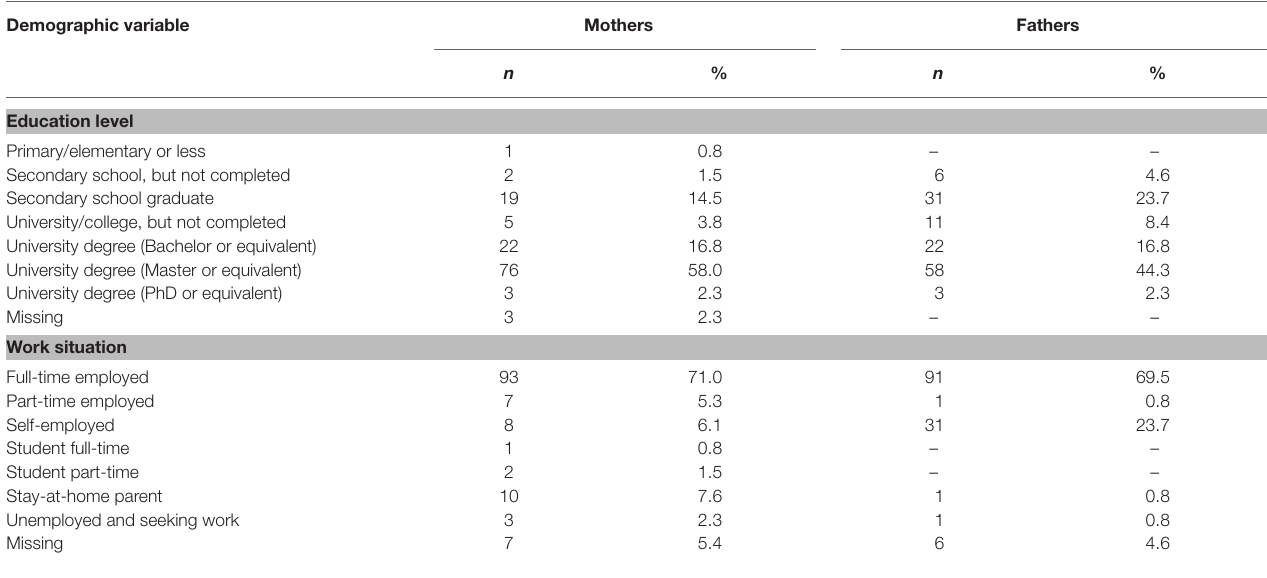
TABLE 1 | Socio-demographic characteristics of the study sample. Demographic